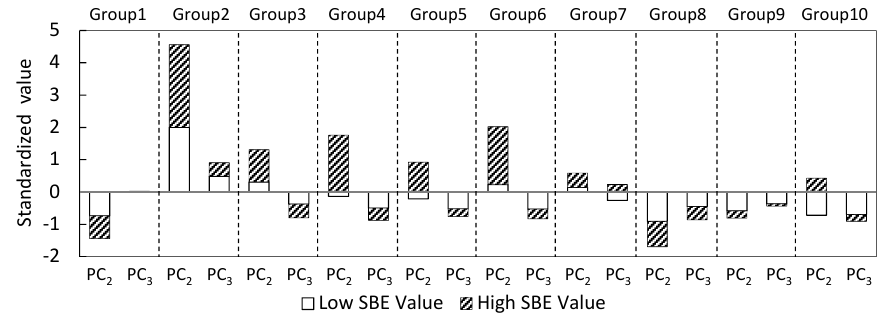
Figure 9. Variation tendencies between PC 2 , PC 3 , and the SBE values in Case 2.